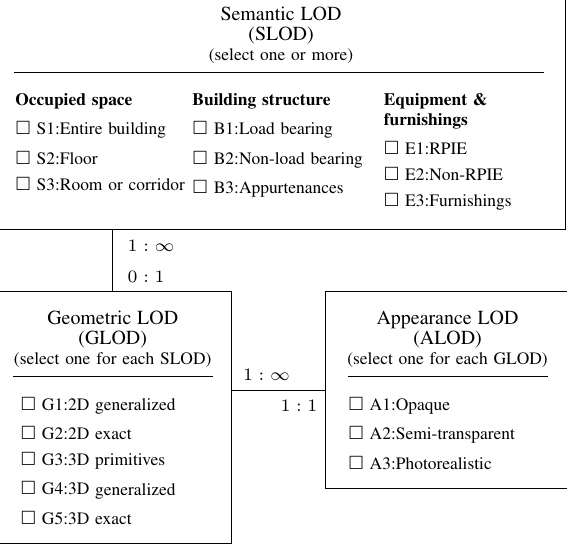
Figure 11. Integration of SLOD, GLOD, and ALOD geometric LOD and, by extension, appearance LOD but will not cover